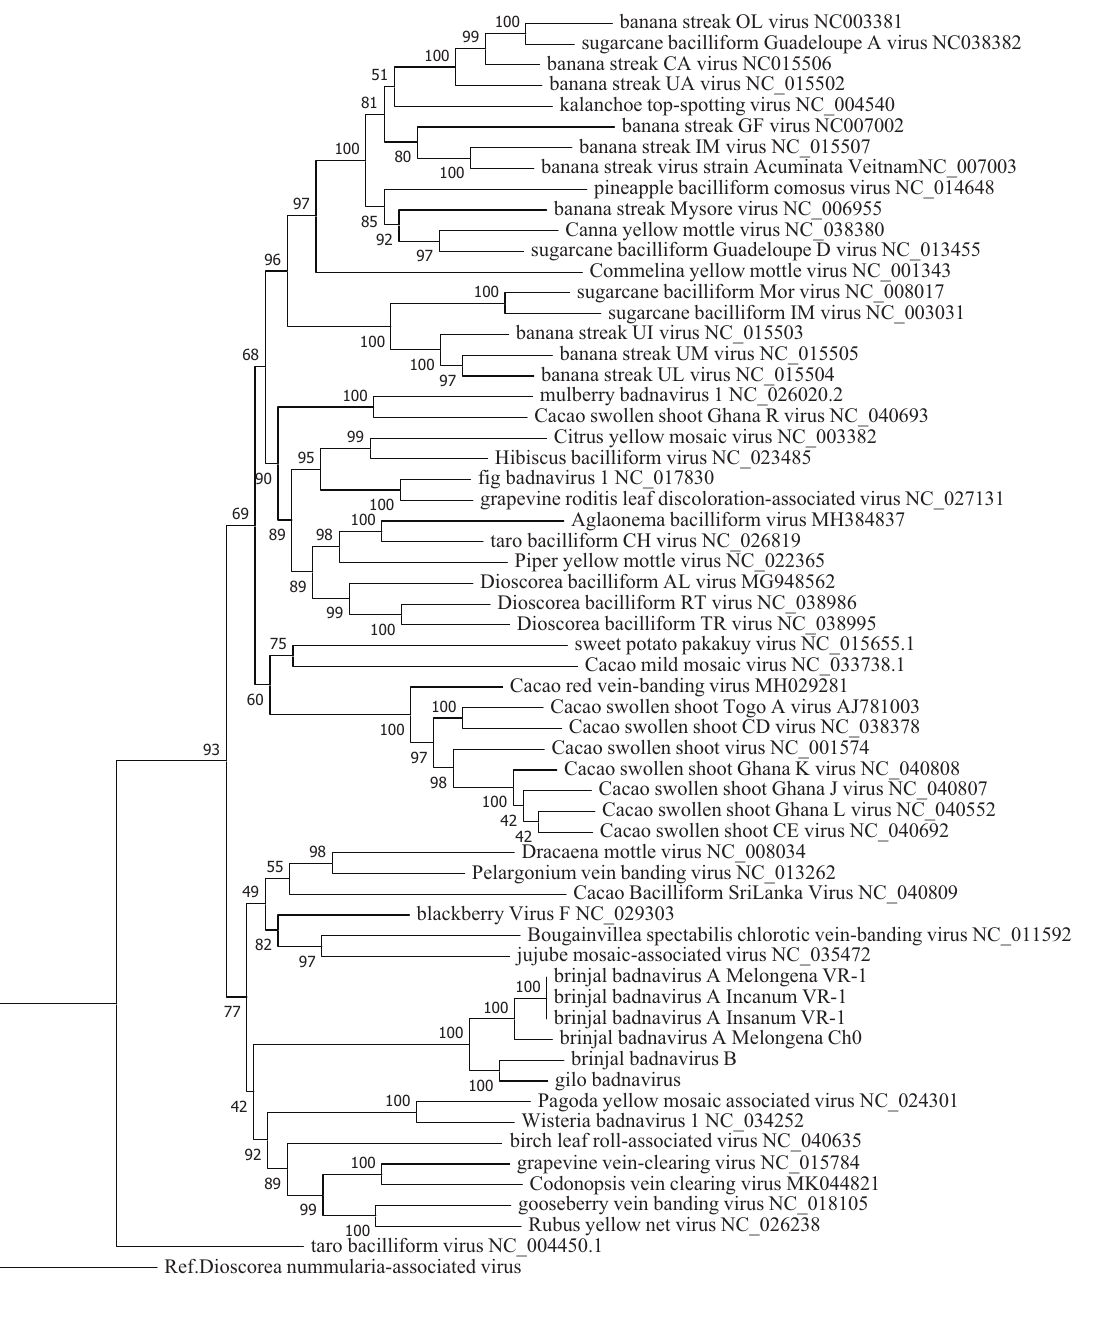
species for which this region could be amplified, cloned